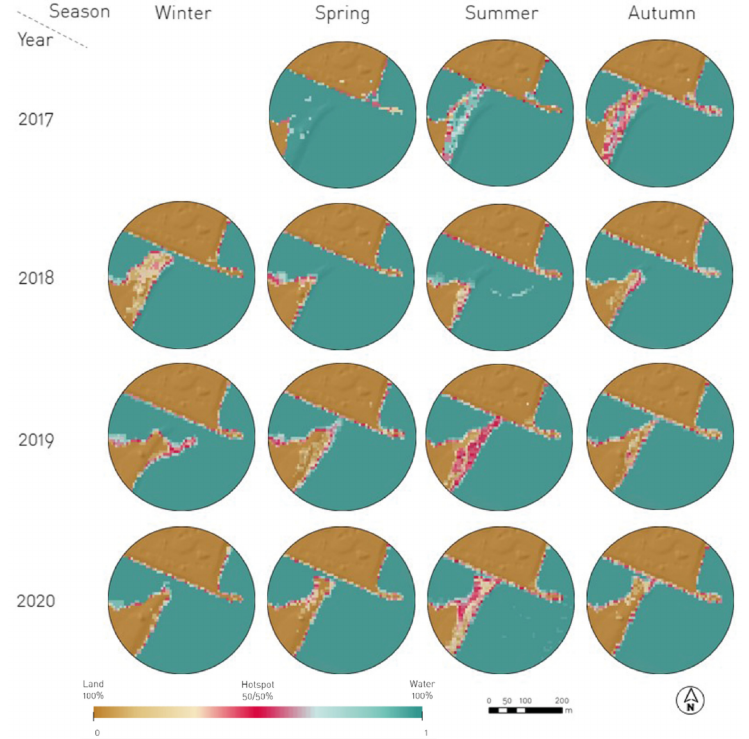
Figure 11. Seasonal variation rate of land/sea interface in the Guadiaro river mouth using Sentinel-2 L2A images and NDWI index from 2017 to 2020. Sand spit variability. Scale